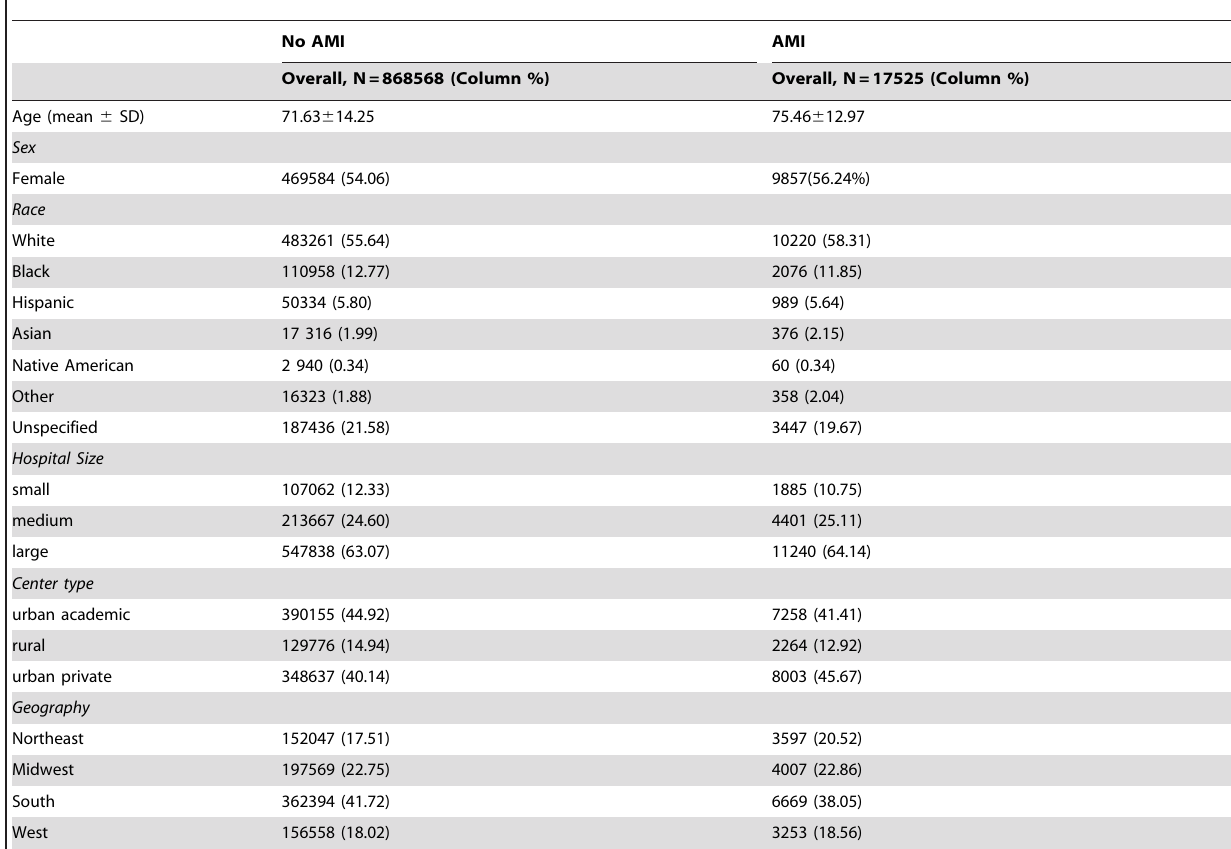
Table 2. Description of ACI patients associated with